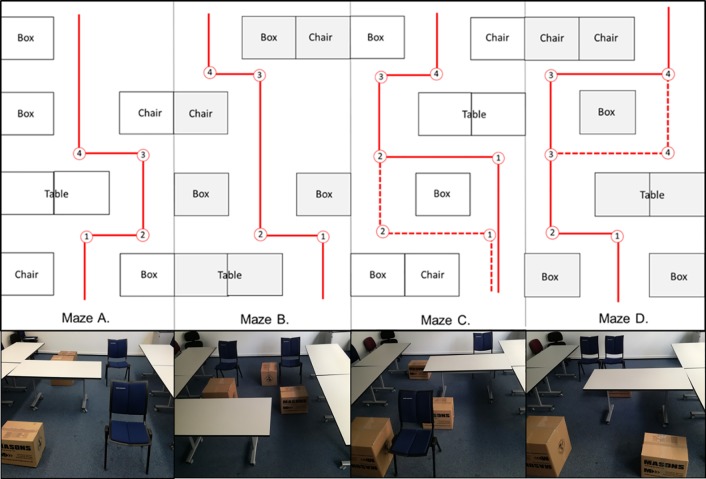
Maze variants.Diagrammatic and photographic images of the four maze variants used (A to D), showing that each variant contains seven objects and four directional changes.